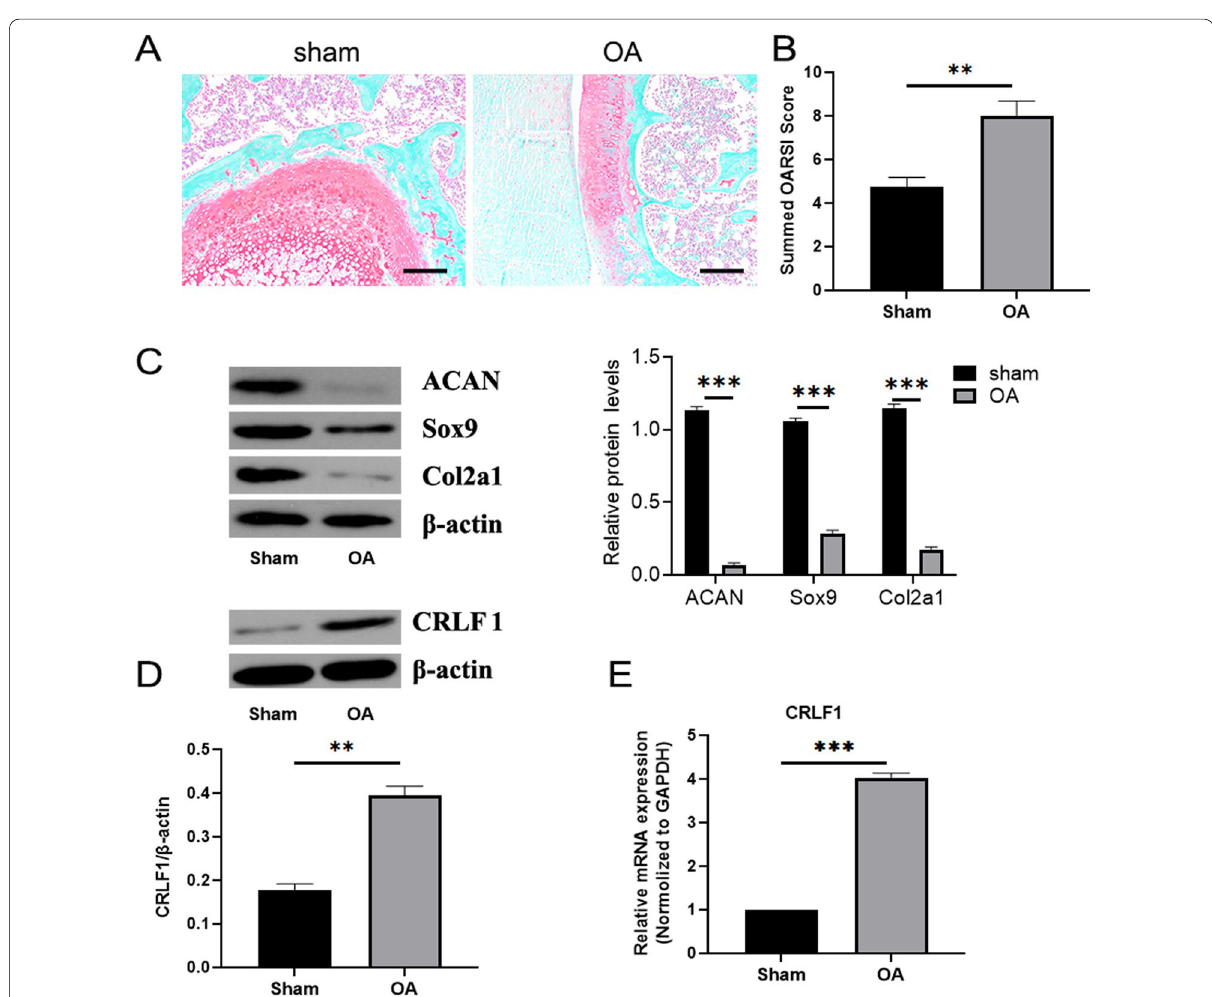
Fig. 1 CRLF1 expression increases in DMM surgery-induced OA mice model. A Paraffin sections of sham and OA cartilage were processed for Safranin-O staining (scale bar, 100 μm), and B quantification of histology by OARSI score based on safranin O staining. C Protein expression levels of ACAN, Sox9, Col2a1 was determined using western blotting. D The mRNA and E protein expression levels of CRLF1 were determined using RT-qPCR and western blotting, respectively. Data are expressed as mean SEM and * P < 0.05, ** P < 0.01, *** P < ±